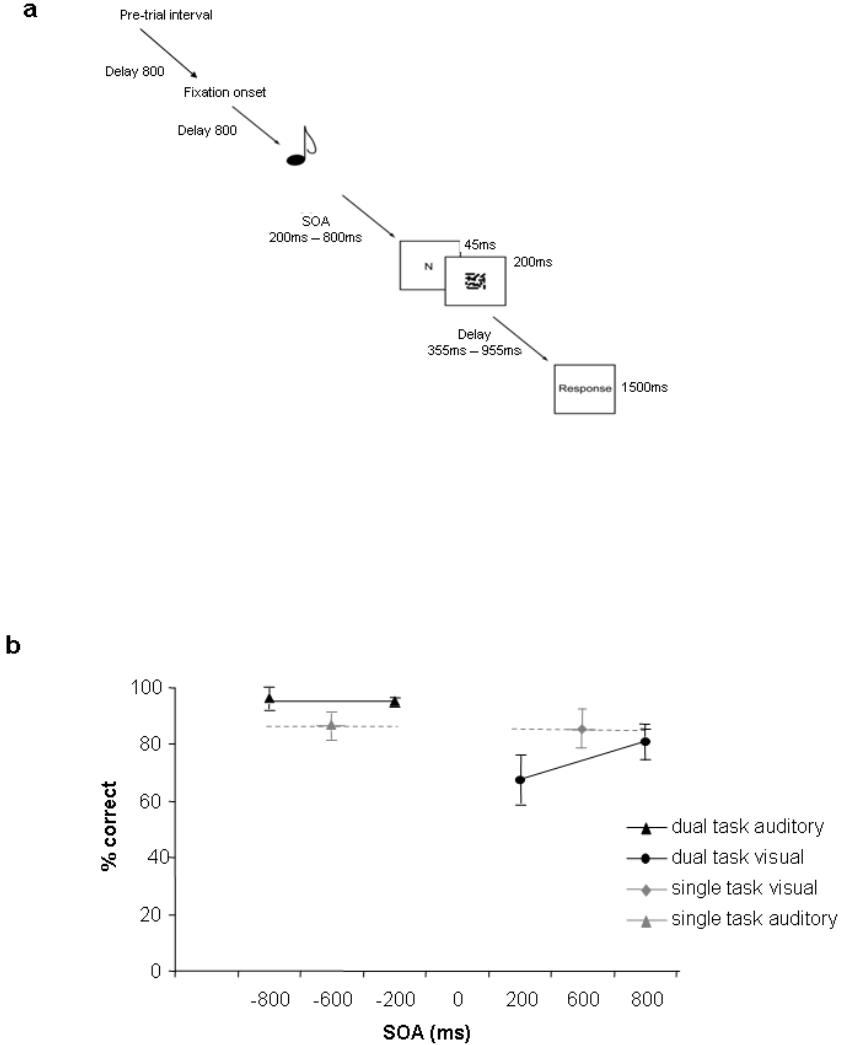
Figure 1. a. Example dual task trial. SOA from tone to letter was 200 or 800 ms. Single task tones and letters (here not shown) occurred at a fixed time (200 ms) from trial onset. b. Behavioural data from fMRI session. For dual task trials, SOA indicates interval between tone and letter, with tone data plotted at negative SOA and letter data at positive SOA. For comparison, single tone and letter data are plotted at a notional SOA. Letter data are for target trials. Error bars indicate standard errors.